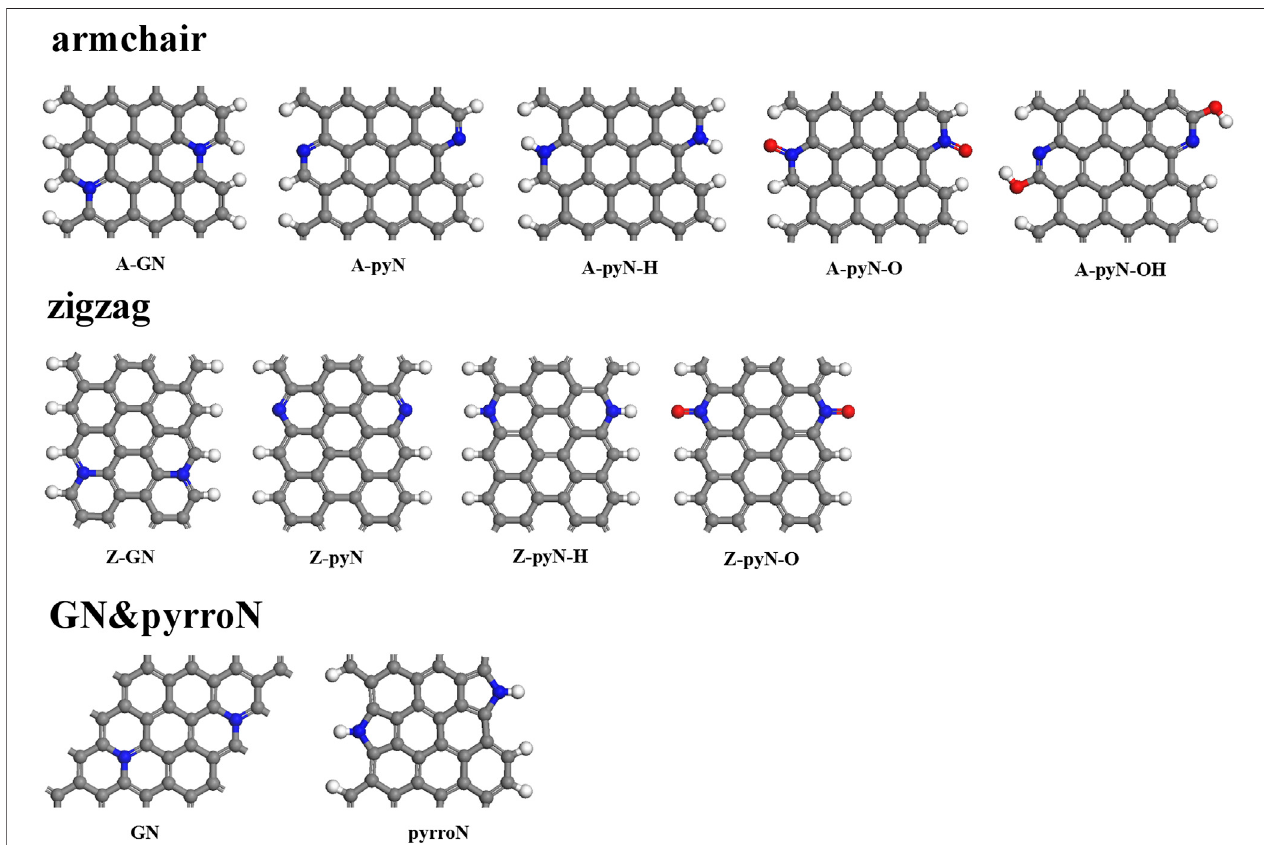
FIGURE 1 | The structures of N-doped graphene. The gray, blue, white, and red balls represent C, N, H, and O atoms, respectively.